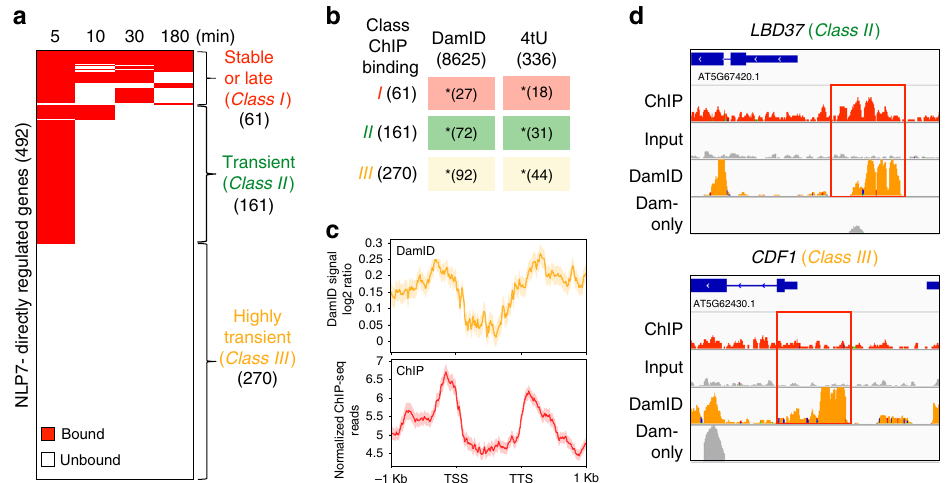
Fig. 2 Transient and highly transiently bound NLP7 actively transcribed targets are captured by time-series ChIP and/or DamID. a Intersection of NLP7 directly regulated genes and NLP7-bound genes captured by time-series ChIP-seq (minutes after DEX-induced nuclear import). Red bars indicate genes that are bound and directly regulated by NLP7. Intersection of these datasets revealed three distinct classes of direct NLP7-regulated targets: (Class I) stable or late, (Class II) transient, (Class III) highly transient. b DamID captures a signi fi cant proportion of genes belonging to all three classes, including NLP7 – target interactions that were missed by ChIP (Class III). Genes from all three classes are enriched in genes whose active transcription is induced by NLP7 (4tU-labeled). Fisher ’ s exact test * p -value < 0.001. c The pro fi le of DamID, indicated by the number of normalized DamID sequencing reads in the 1000-bp upstream regions of TSS to the 1000-bp downstream regions of TTS. The DamID pro fi le is similar to the ChIP pro fi le, indicated by the normalized ChIP-seq reads. d LBD37 is an example of active NLP7-initiated transcription (4tU) where binding is captured by both DamID (orange) and ChIP (red). CDF1 is an example of active NLP7-initiated transcription in which TF binding is captured by DamID, but missed by